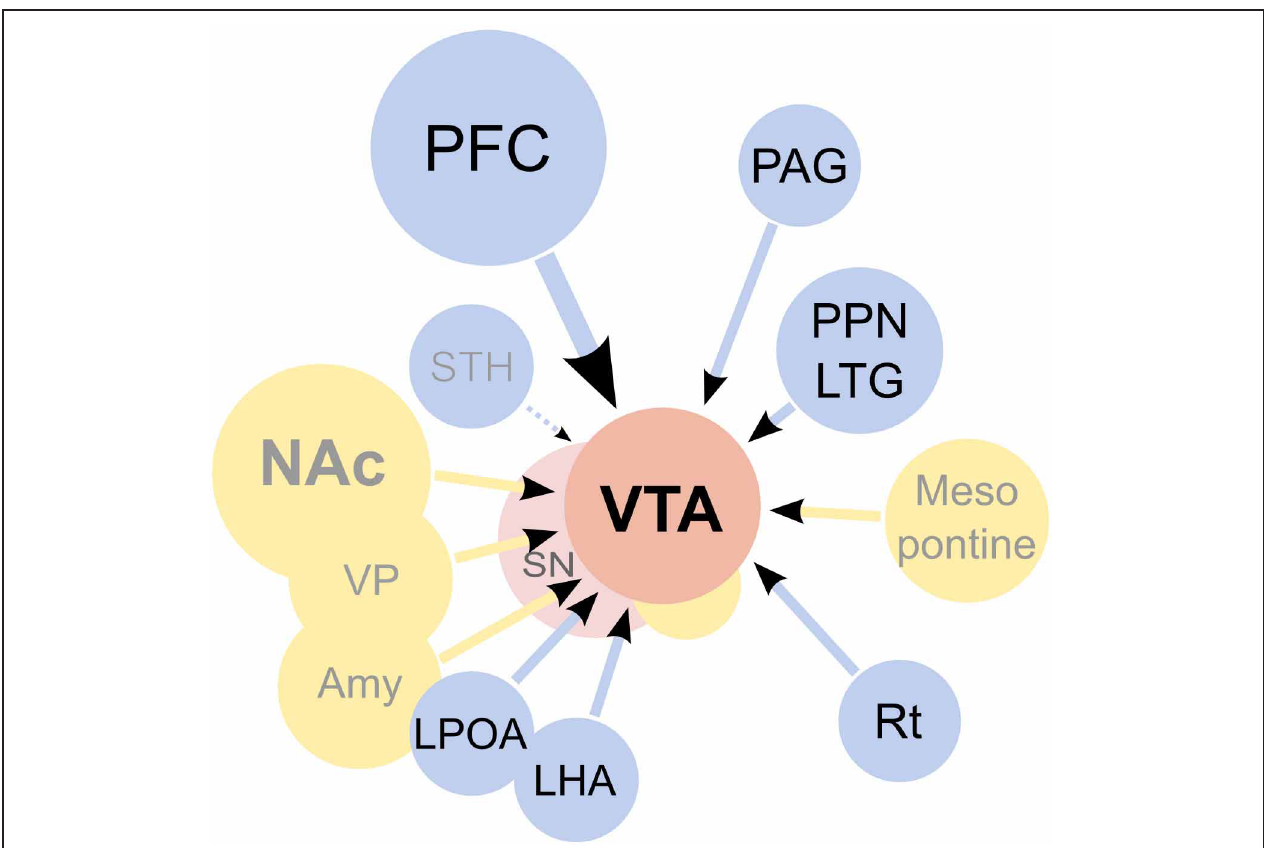
FIGURE 4 | Afferents to the ventral tegmental area (VTA). On the diagram, origins of the main excitatory inputs are shown as blue circles, origins of the main inhibitory inputs as yellow circles, and the VTA and substantia nigra (SN) as red circles. Excitatory inputs originate from the prefrontal cortex (PFC), periaqueductal grey (PAG), the pedunculopontine nucleus (PPN), the laterodorsal tegmentum (LTG), lateral hypothalamus (LHA), lateral preoptic area (LPOA) and the reticular formation (Rt). The subthalamic nucleus (STH) was reported to send projections to the SN but not the VTA. It should be noted that the excitatory projections are forming synapses not only on dopaminergic cells, but on other types of